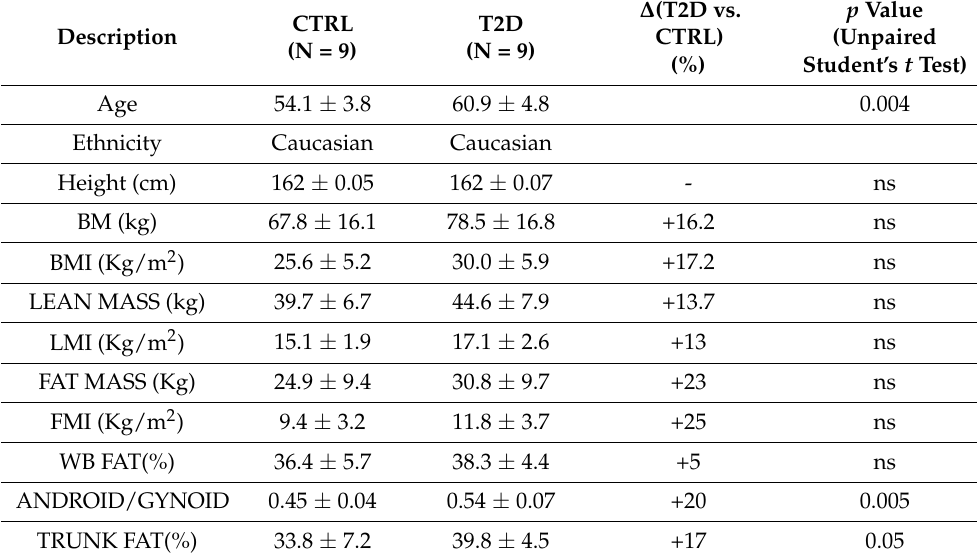
Table 1. Anthropometric characteristics of body composition and fat distribution of the participants. Data relative to each parameter were compared using unpaired Student’s t test. Data are expressed as mean ± st.dev; (CTRL N = 9; T2D N = 9).